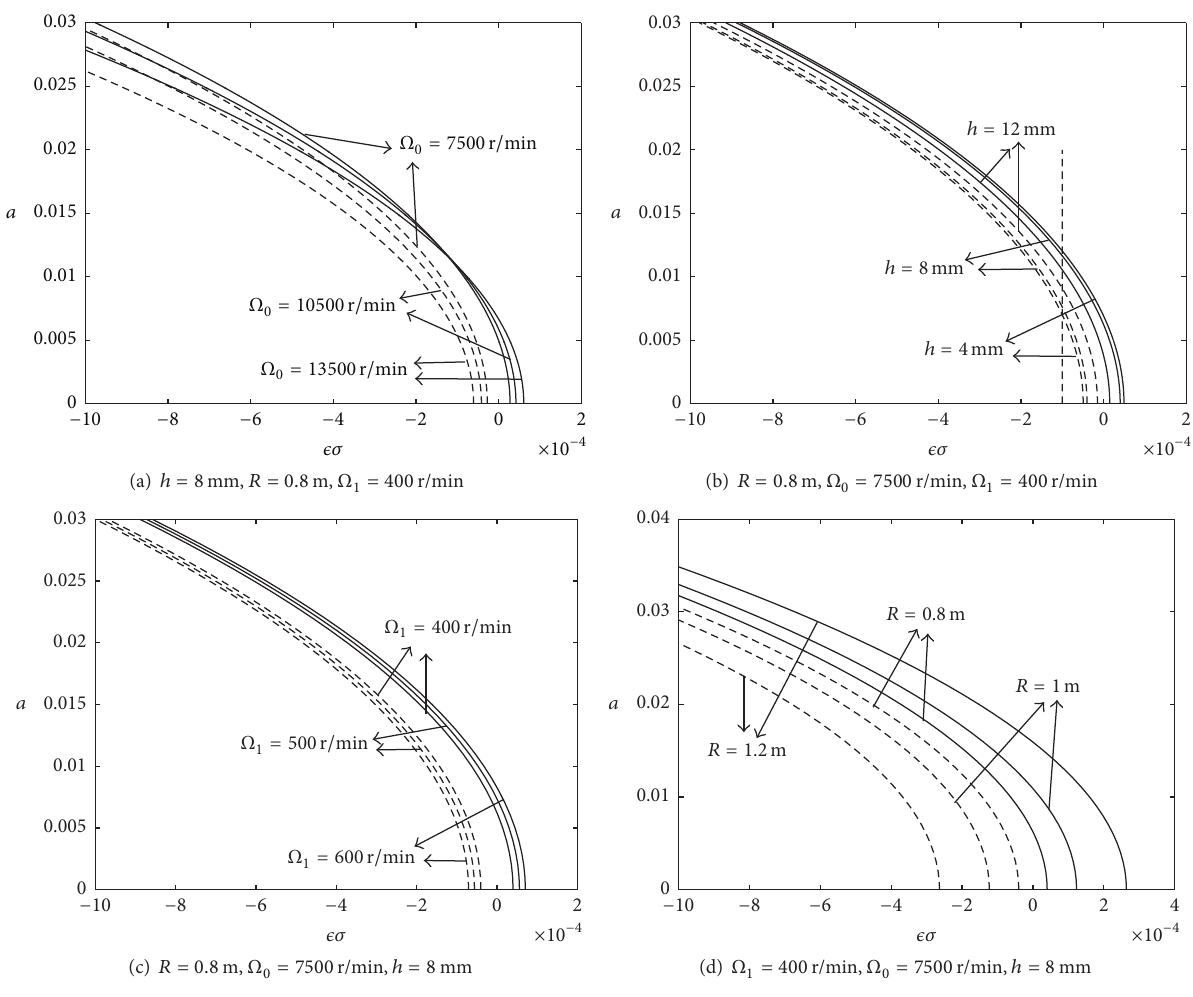
Figure 3: Amplitude-frequency response curves.